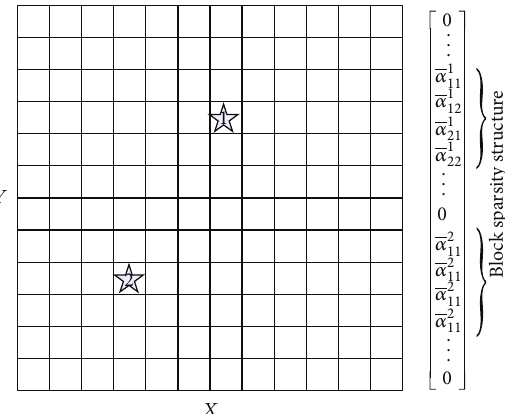
Figure 1: The spatial sparsity of the targets inside the area is illustrated through discretization of the area into a grid of 𝐺 cells. The targets occupy only two cells marked as 1 and 2 . Hence, the spatial representation of the target reflection coefficients is sparse. We can see that support of w exhibits the block sparsity structure as there are only two blocks of nonzero elements corresponding to the two targets. The size of each block is the number of transmit-receive